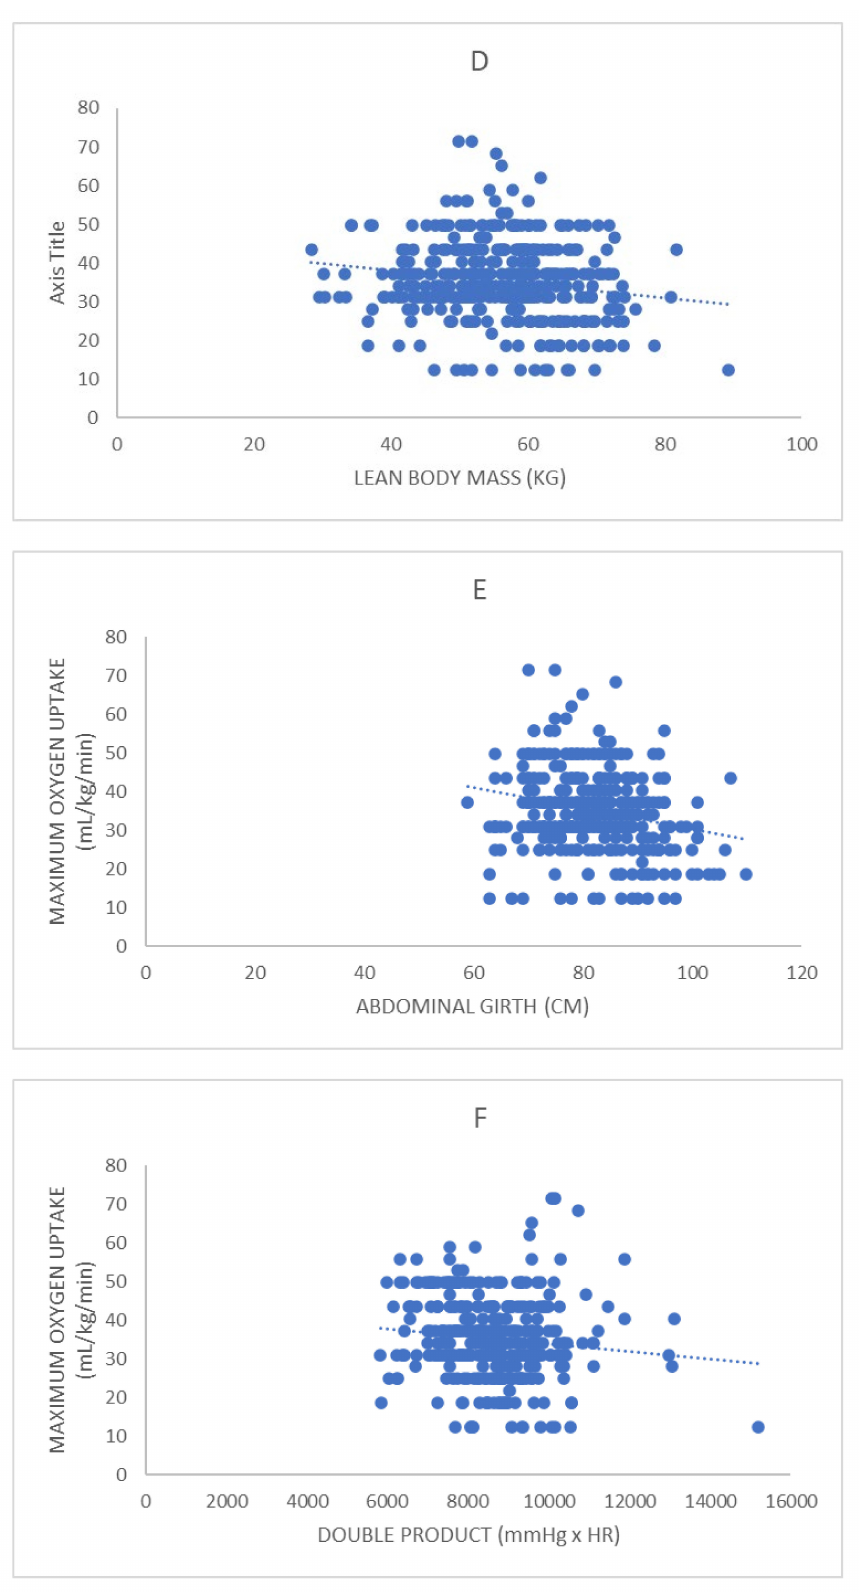
Figure 4. Correlation between the study participants’ maximum oxygen uptake and the anthropo- metric and health variables with which it maintained a significant correlation: ( A ) weight; ( B ) body mass index; ( C ) body fat percentage; ( D ) lean body mass; ( E ) abdominal girth; ( F ) double